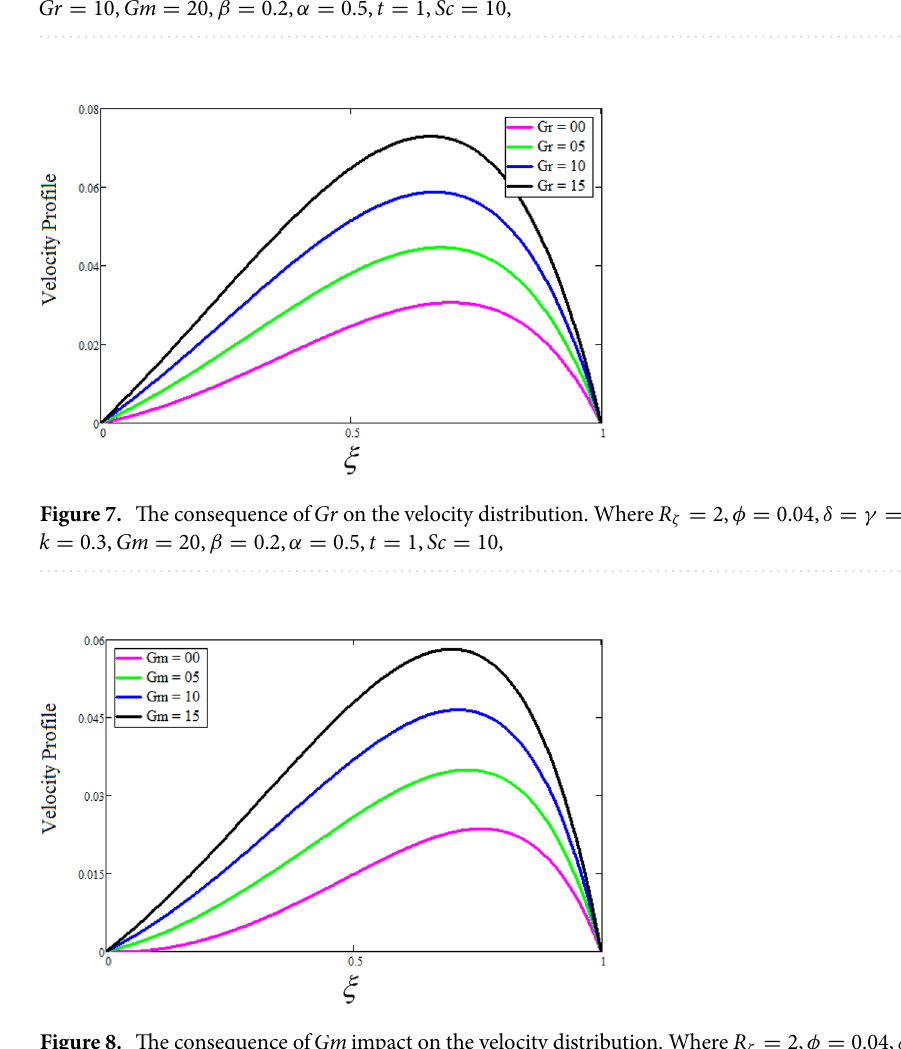
Figure 6. The consequence of k on the velocity distribution. Where R ζ = 2, φ = 0.04, δ = γ = π 3 , M = 5, Gr = 10, Gm = 20, β = 0.2, α = 0.5, t = 1, Sc = 10,